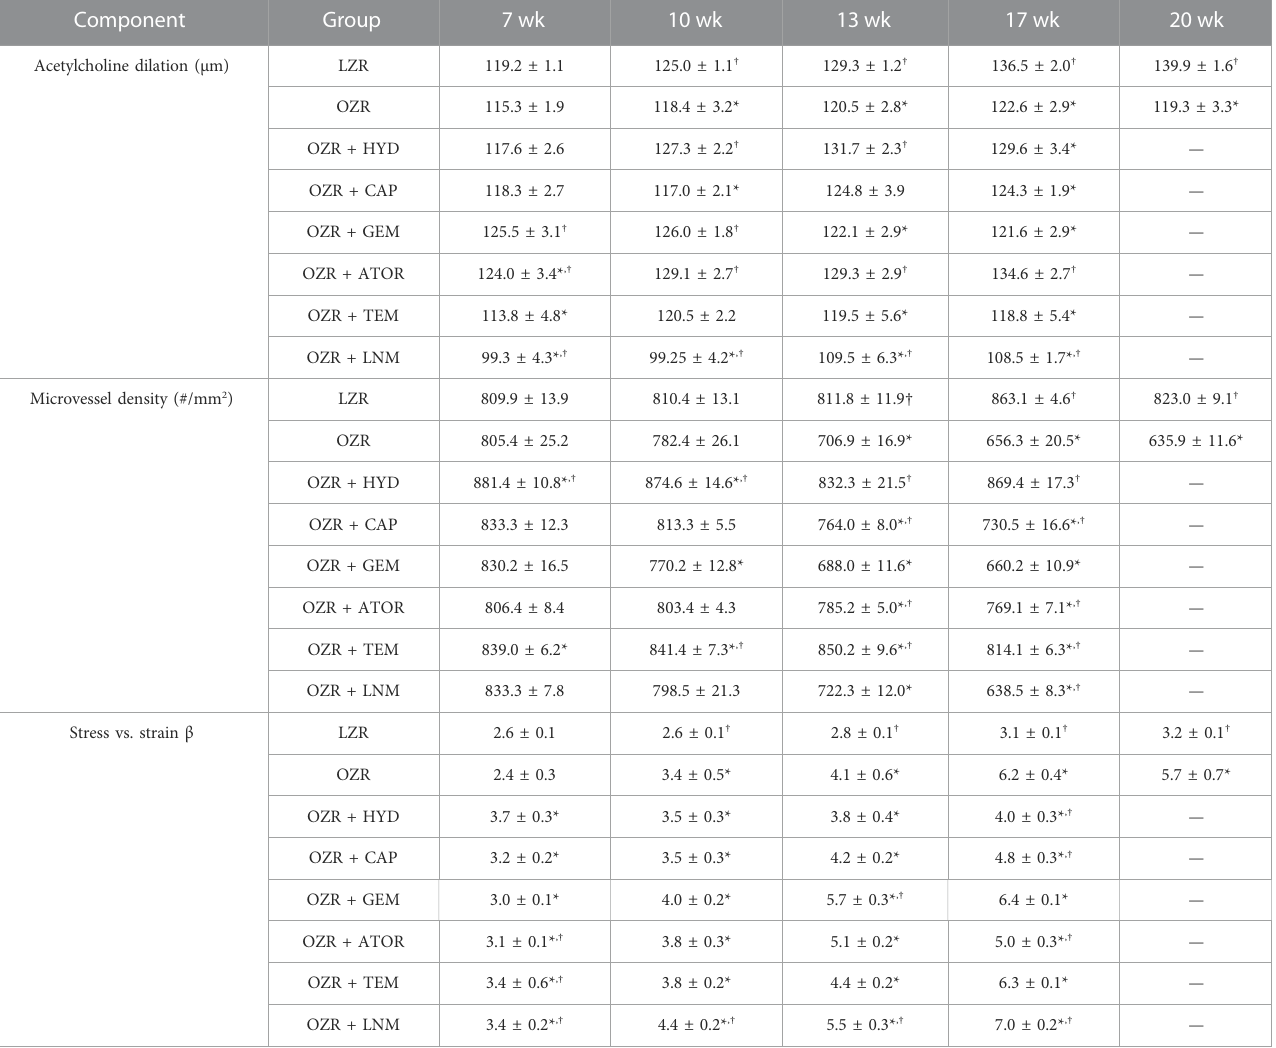
TABLE 4 Skeletal muscle vascular component data, presented as mean ± SE246, for the animal groups of the present study across all age.